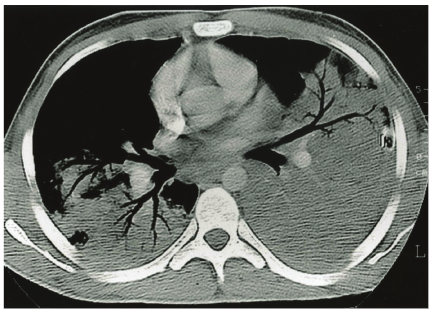
Figure 2: Thoracic CT scan on the 7th day after hospitalization showing a bilateral pneumonia with pleural